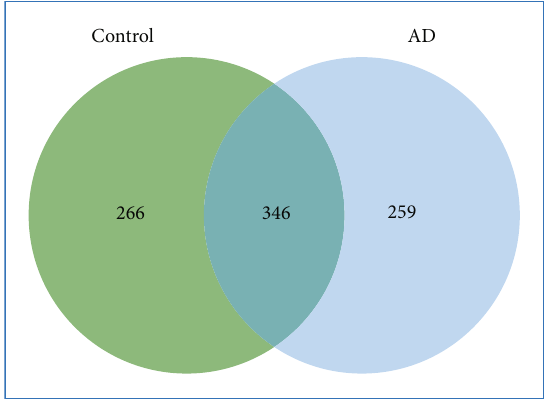
Figure 1: Venn diagrams displaying the number of identi fi ed unique glycoproteins for control and AD